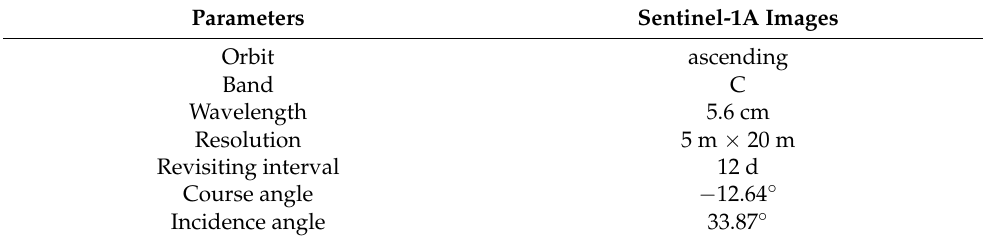
Table 3. Parameters of Sentinel-1A images.